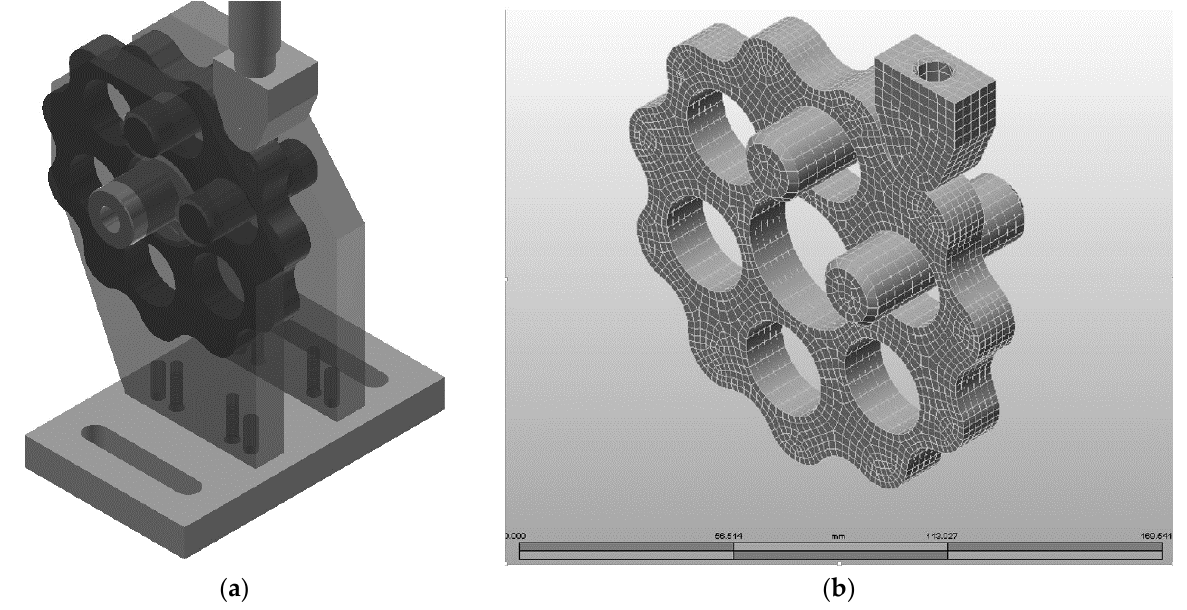
Figure 8. CAD model of a segment of the cycloid speed reducer: ( a ) experimental analysis ( b ) FEM analysis.